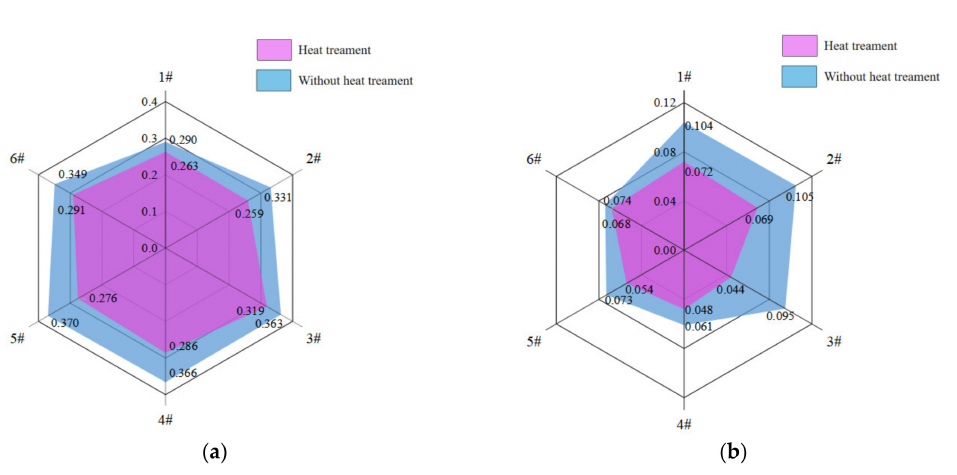
Figure 11. Average friction coefficient of samples 1#~6# under different lubrication conditions. ( a ) Dry friction; ( b ) Starved